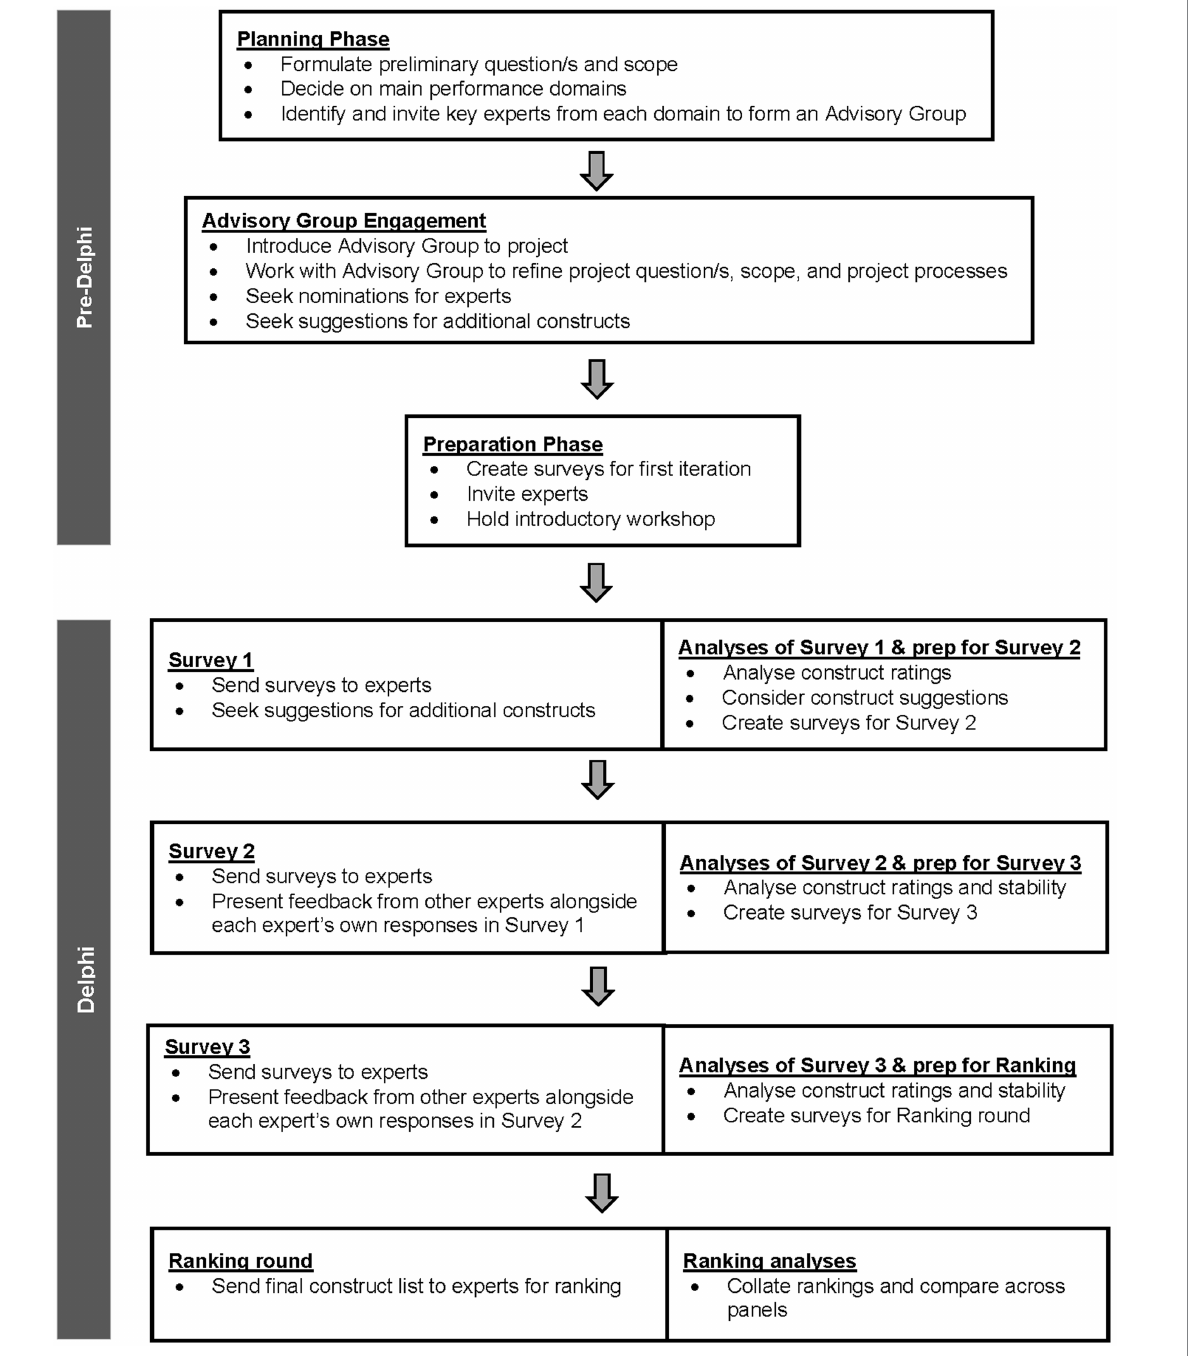
FIGURE 1 A visual representation of pre-Delphi and Delphi